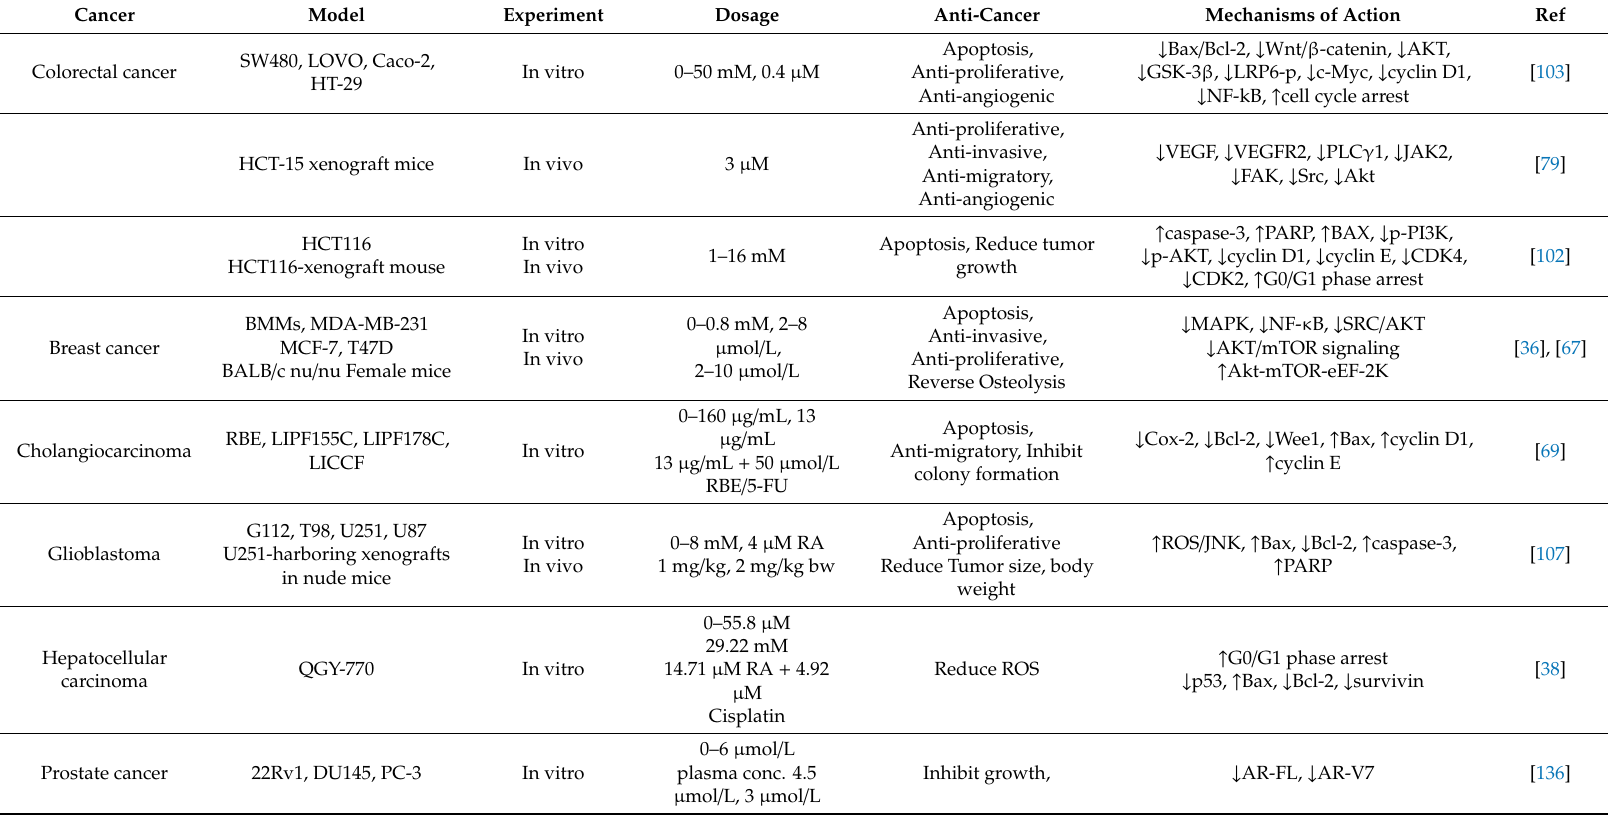
Table 1. A list of di ff erent cancers a ff ected by RA under in vitro and in vivo